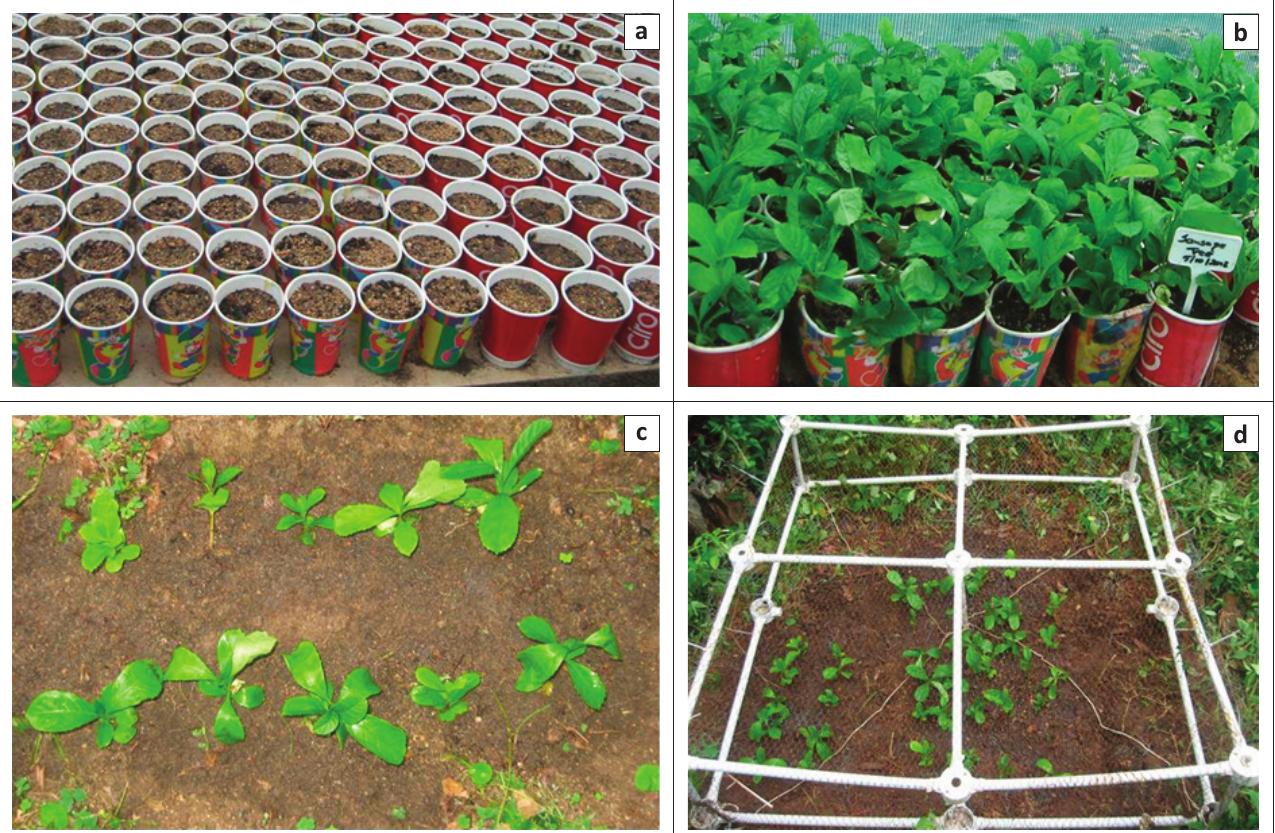
FIGURE 2: (a) Paper cups used for germination of Kigelia africana , (b) Kigelia africana seedlings before they were transferred to the ground for the herbivory experiment, (c) a plot of 10 planted seedlings, and (d) example of a wire-mesh enclosure used to exclude all